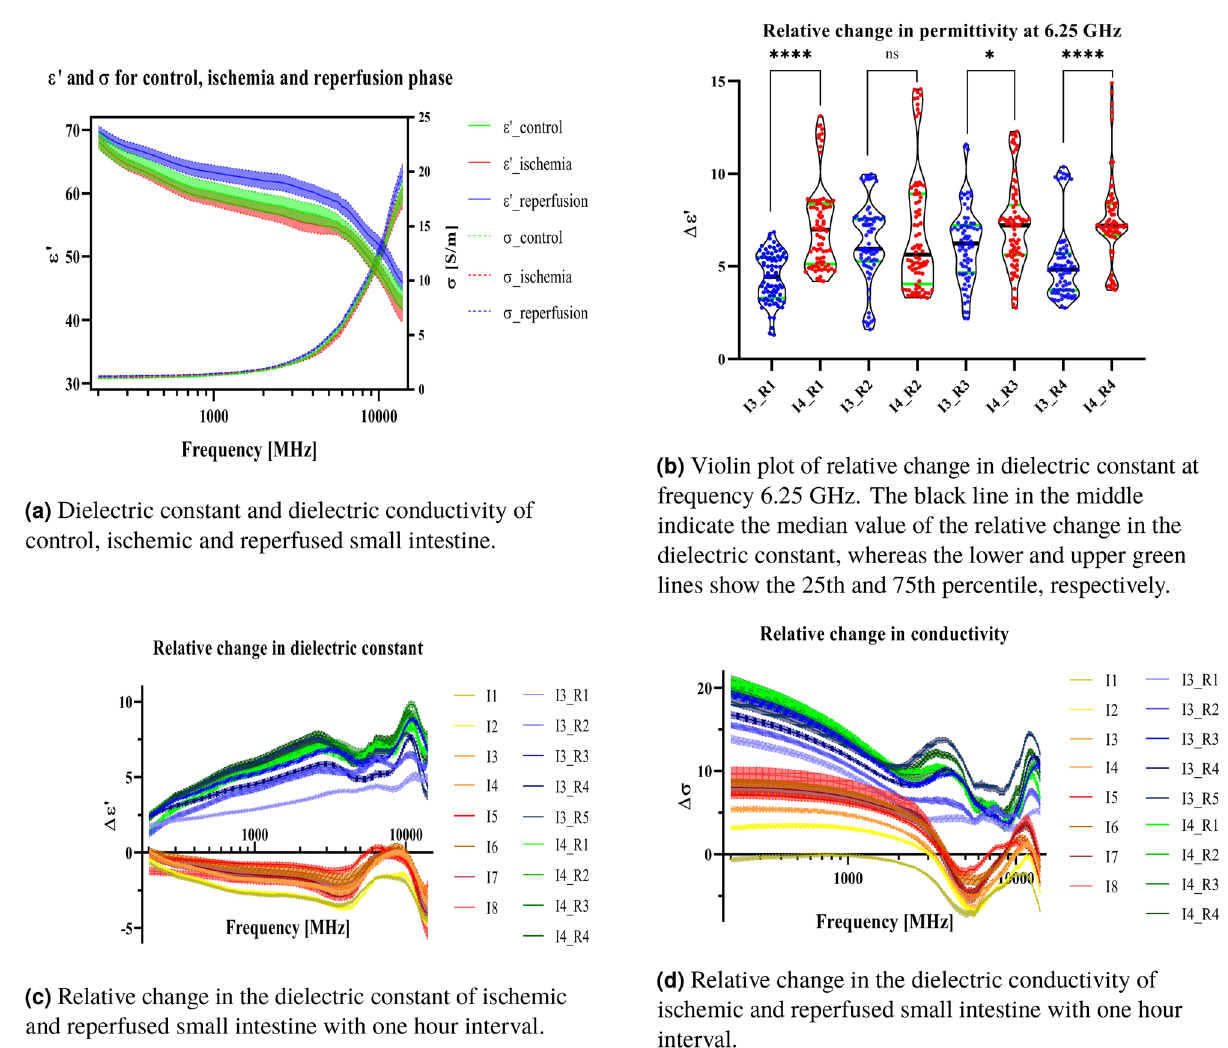
Figure 1. Dielectric constant and dielectric conductivity plots of control, ischemic and reperfusion phase of the small intestine with mean value and 95% confidence interval. “I” = Ischemia and “R” = Reperfusion, numbers are shown in hours. Significant codes: ≤ 0.0001 “ ∗ ∗ ∗∗ ”, ≤ 0.05 “ ∗ ”, Not significant, “ns”. Frequency range is 200 MHz–14 GHz.